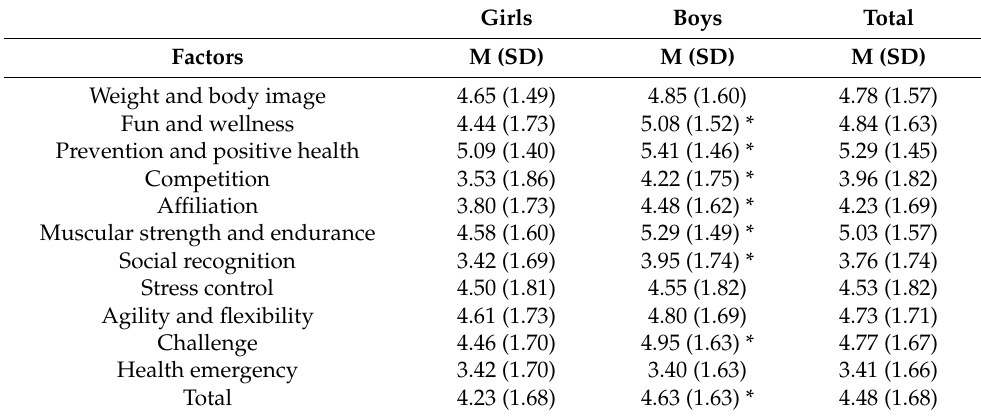
Table 2. Descriptive results of the AMPEF factors, by